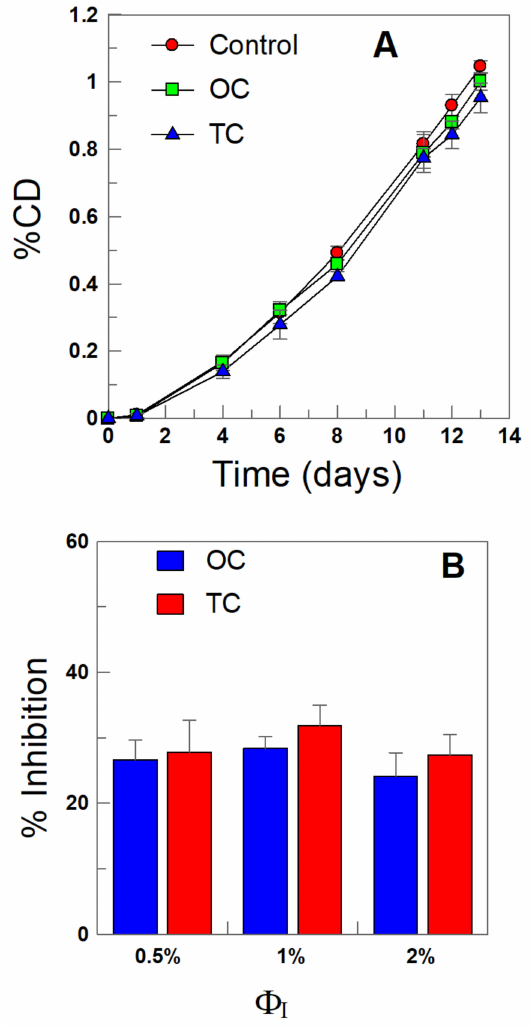
Figure 2. ( A ) Kinetics of production of primary oxidation products in 4:6 corn oil emulsions in the presence and absence of OC and TC ( Φ I = 0.01) as determined by the variation in the formation of conjugated dienes with the time. T = 55 ◦ C. ( B ) Percentage of inhibition of OC and TC on the formation of conjugated dienes at different surfactant volume fractions ( Φ I = 0.005, 0.01, and 0.02). Values determined by employing Equation (9) with data extracted from Figure 2A (day